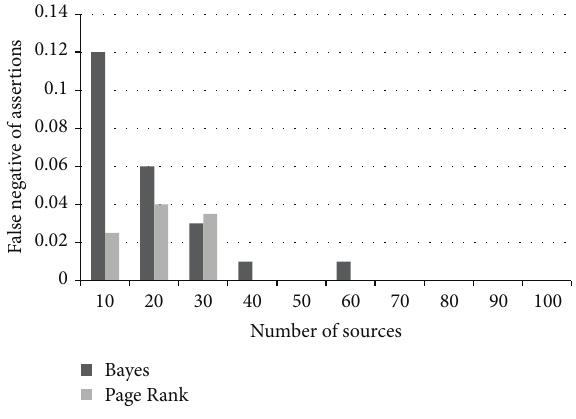
Figure 5: Prediction